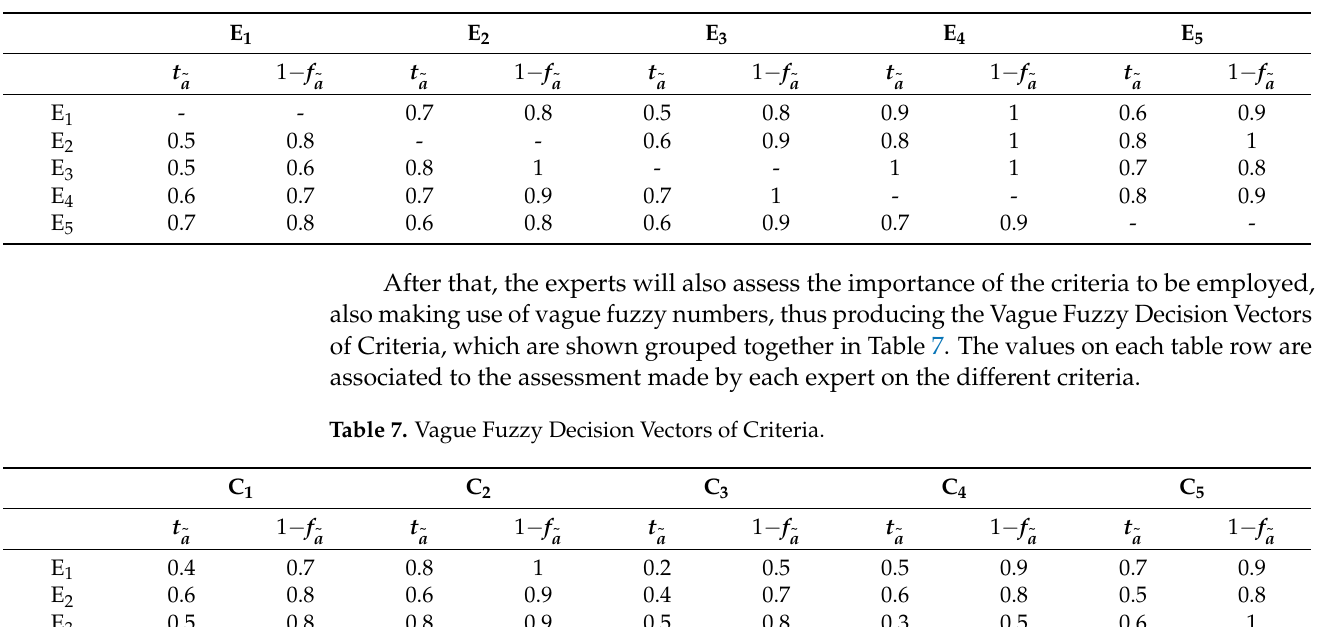
Table 6. Vague Fuzzy Decision Vectors of Experts.